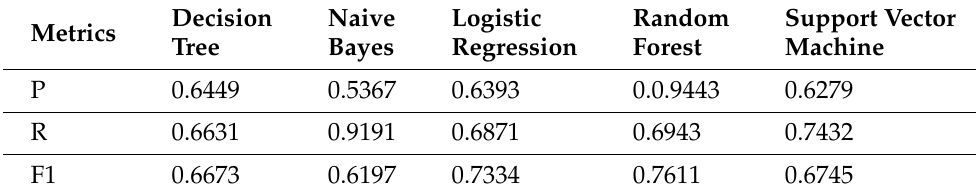
Table 7. Average score of different classifiers.